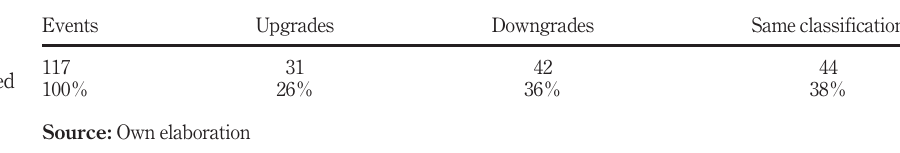
Table 1. Number of analysed events and